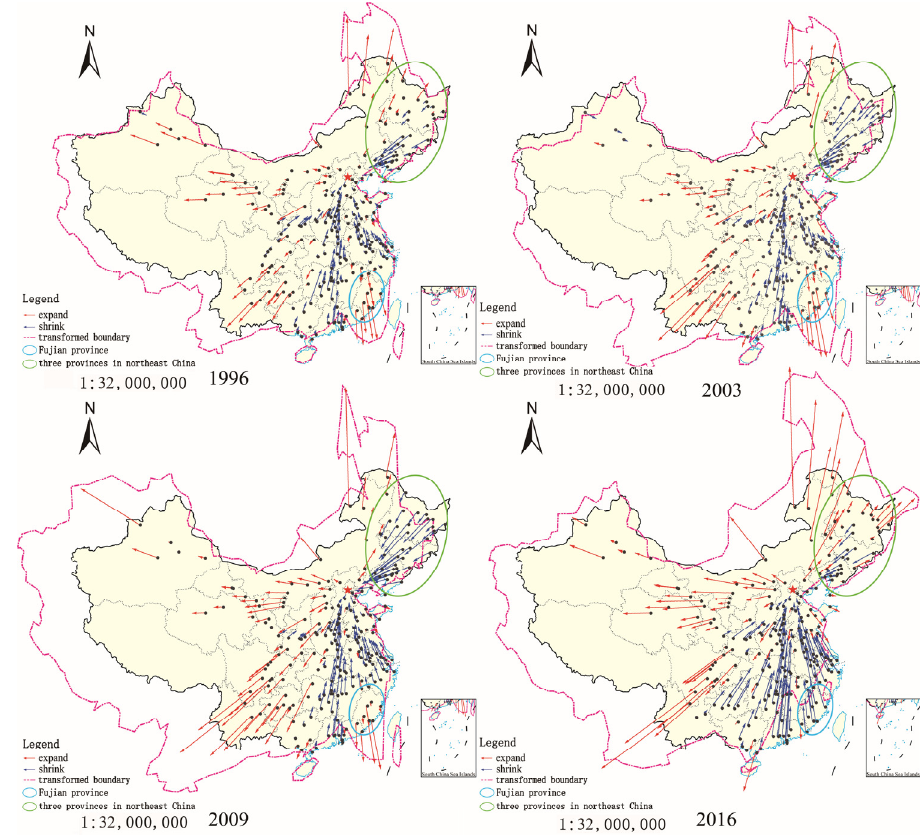
Figure 6. Comparison of transformed results for the years 1996, 2003, 2009 and 2016 (Maps in this figure are demonstrations of experiment results, not the real territory of the study area).